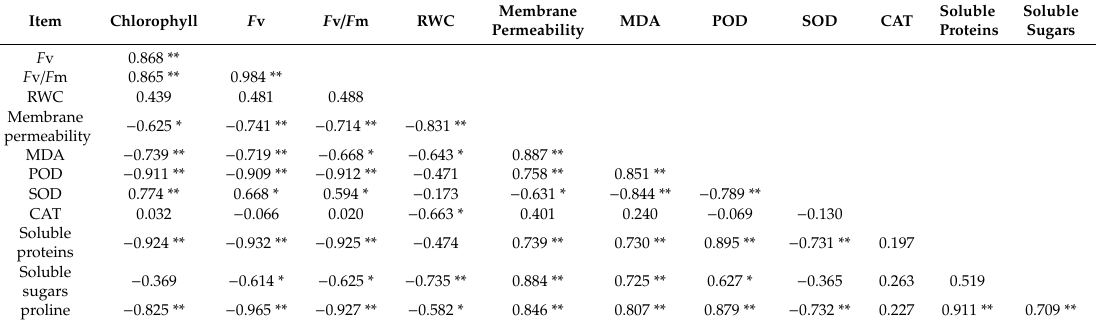
Table 1. Pearson’s correlation coe ffi cient ( r ) for the relationships among the physiological characteristics for all drought durations including rehydration in A. halodendron . Abbreviations: F v , variable chlorophyll fluorescence; F v / F m , quantum e ffi ciency of photosystem II; RWC, relative water contents; MDA, malondialdehyde; POD, Peroxidase; SOD, superoxide dismutase; CAT,